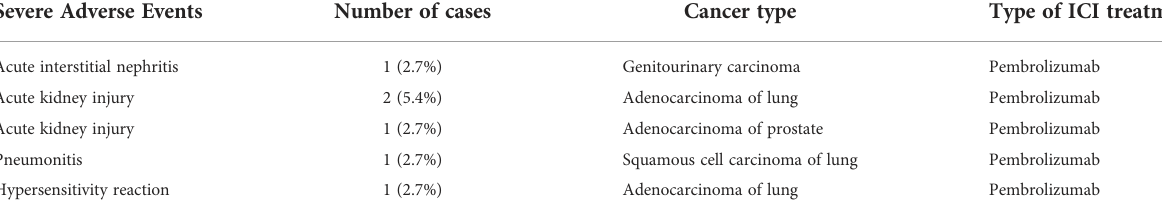
TABLE 3 Immune related severe adverse events (grade 3 or